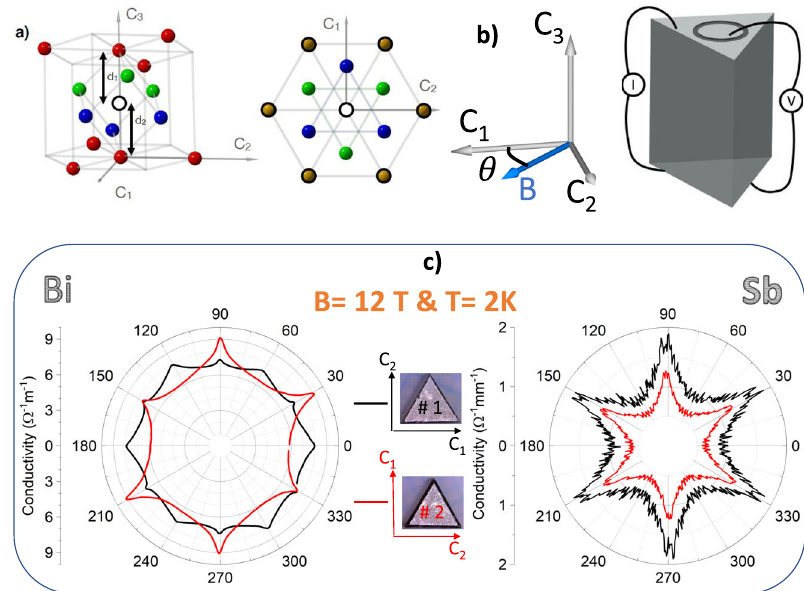
Fig. 2 Crystal structure, triangular prisms, and angle-dependent magnetoconductance. a Left: Rhombohedral crystal structure of bismuth and antimony. C 1 , C 2 , and C 3 refer to bisectrix, binary and trigonal axes. Note that all atoms are not shown and d 1 > d 2 . Right: Projection to the trigonal plane. The central atom is surrounded by its fi rst (in green), second (in blue), and third (in yellow) neighbors. Atoms with bold black rings belong to the same sub-lattice. b Experimental con fi guration for measuring angle-dependent magnetoresistance. The current electrodes were made large enough to cover most of the surface and the voltage electrodes were small circles. c Angle-dependent magnetoconductivity in two triangular prism-shaped crystals which are identical in shape, but whose faces are tilted by 30 degrees. In Bi (left), the low-temperature angle-dependent magnetoresistance is dissimilar in the two samples, but in Sb (right), they remain identical. Fine features in the angle-dependent conductivity of Sb are caused by evacuation of Landau levels upon